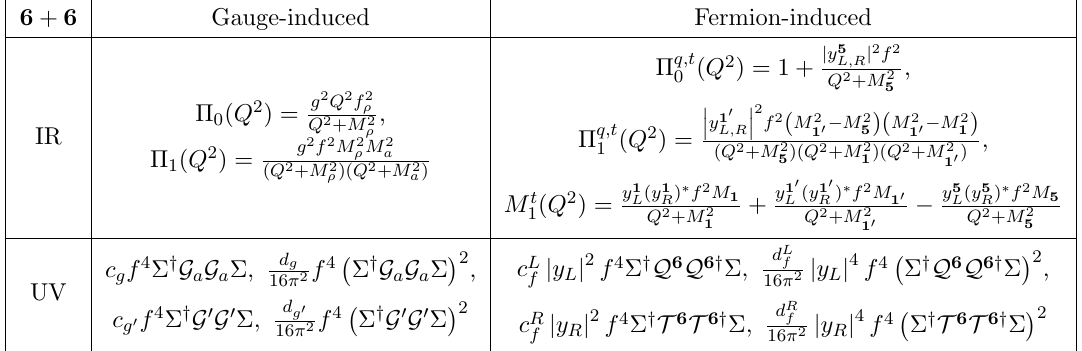
Table 2 . The contributions to the scalar potential in the 6 + 6 NMCHM. Note that this table is a realization of table